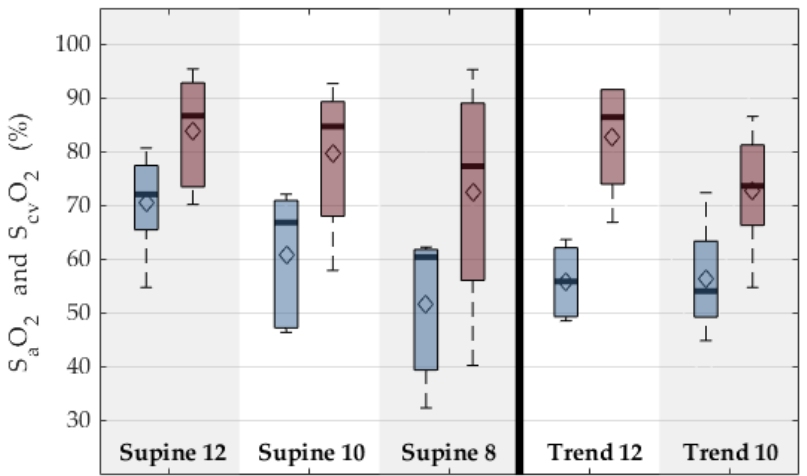
Figure 12. Mixed venous and arterial oxygen saturations for supine position and reverse Trendelen- burg. Each column depicts one group of the experimental sequence. Supine: animal was positioned flat on the back; Trend: 45 ◦ reverse Trendelenburg position, simulating a mobilized patient; and 12,10,8: respiratory rate of the intermittent mechanical ventilation, simulating hypercapnic respiratory failure. Blue depicts venous values, and red depicts arterial values. Boxplots show 95%-CI (whiskers), 50% interval (box), median (black bar), and mean (diamond).